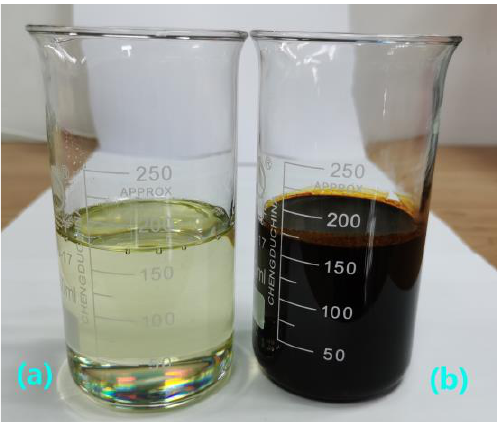
Figure 12. Epoxy resin used in this study: ( a ) epoxy oligomer and ( b ) hardener.